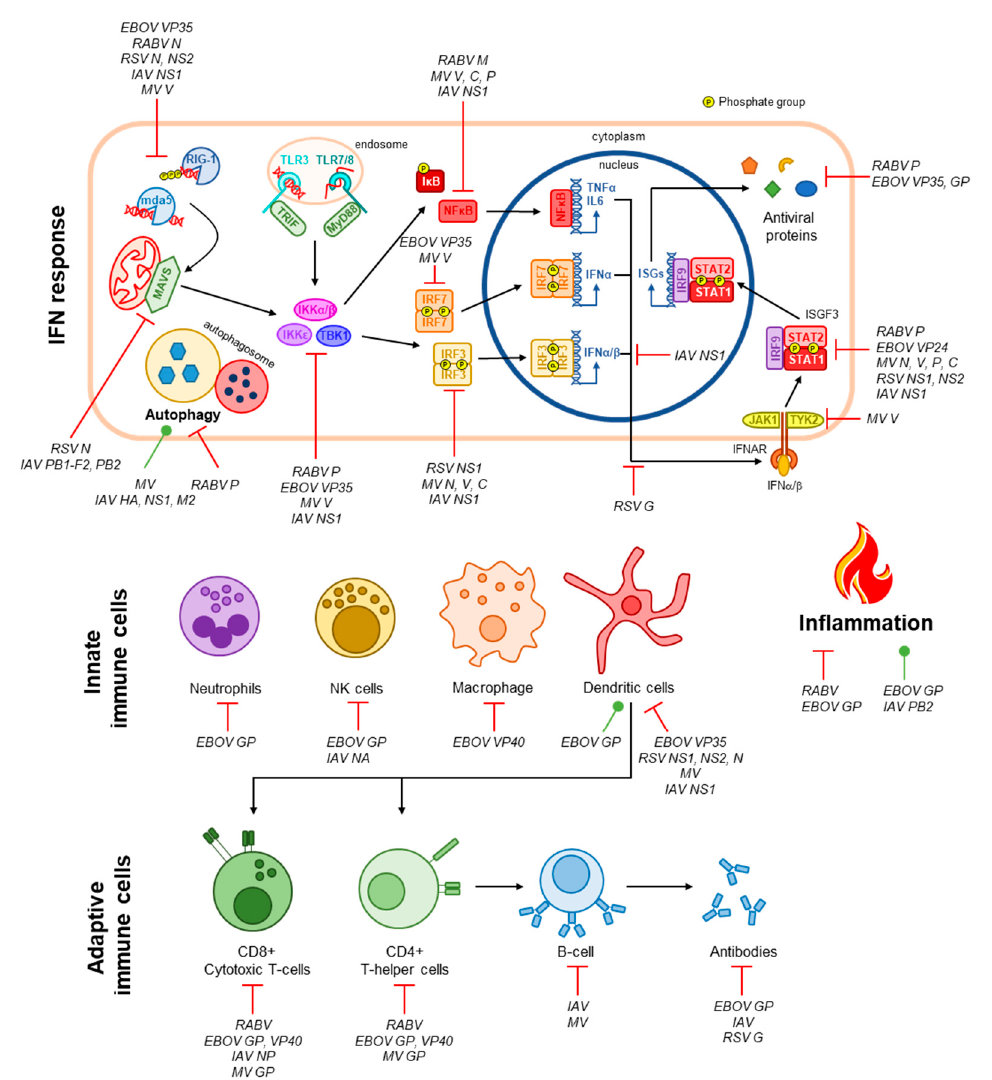
Figure 1. Immune evasion by NSVs. The IFN response is the primary antiviral pathway activated following virus infection. NSVs are detected by intracellular PRRs such as RIG-1 and mda5 in the cytoplasm or TLR3/7/8 in the endosomal compartment via interactions with viral RNA [12]. Signalling cascades involving MAVS (for RIG-I and mda5) or TRIF/MyD88 (for TLRs) result in the activation of the kinases IKK α / β / ε and TBK1 that subsequently activate the latent transcription factors IRF3, IRF7, and NF κ B via phosphorylation [12]. These transcription factors promote the expression and secretion of proinflammatory and antiviral cytokines (TNF α , IL-6, and IFN α / β ) [12]. IFNs signal in an autocrine and paracrine manner by binding to the IFN α / β receptor (IFNAR), resulting in the activation of the ISGF3 complex (STAT1, STAT2, and IRF9) through phosphorylation of STAT1 and STAT2 by IFNAR-associated kinases JAK1 and TYK2 [12]. ISGF3 then promotes the expression of antiviral genes [12]. Innate and adaptive immune cells, as well as inflammation and autophagy, which additionally contribute to viral clearance, are also depicted. Targeting of the antiviral immune response by NSVs, and the viral proteins involved if known, are indicated [33–51].